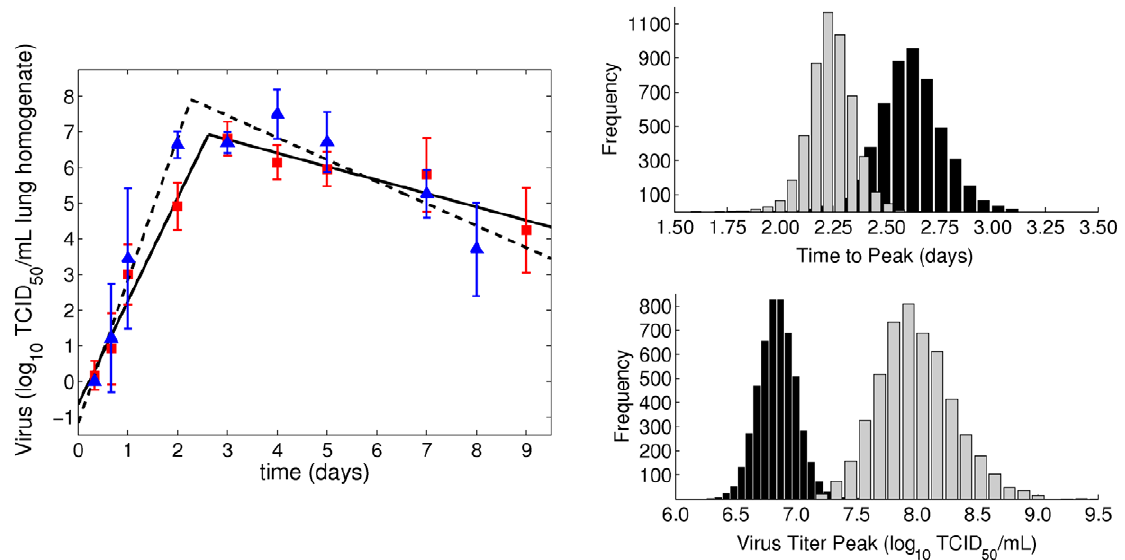
Figure 2. Log-linear fits to lung viral titers in Phases I and II of an influenza infection with PR8 (solid line, squares) or PR8-PB1- F2(1918) (dashed line, triangles). The number of data points included in each phase was determined by finding the two lines that produced the maximum likelihood fit. No data point was allowed to be included in both phases. Distributions of peak times (days) and titers ( log 10 TCID 50 = ml lung homogenate ), PR8 - black and PR8-PB1-F2(1918) - gray, from bootstrap replicates of the log-linear fits.